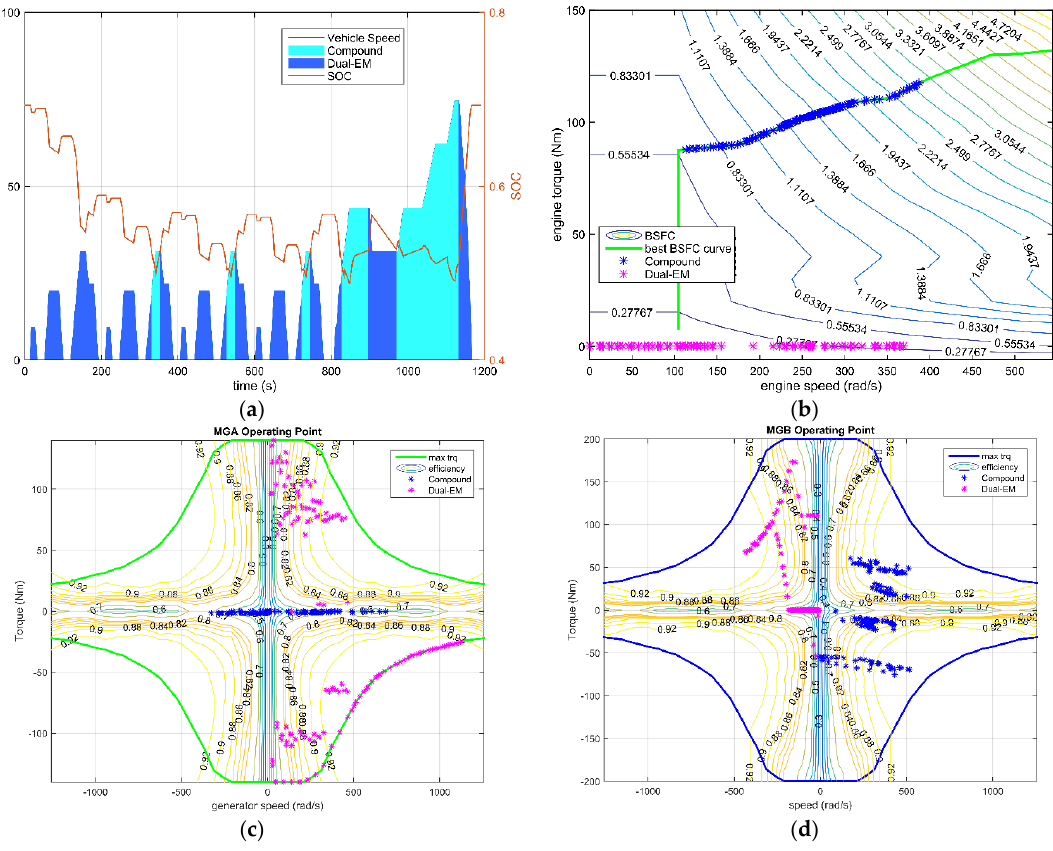
Figure 14. ( a ) Battery SoC trajectory and mode selection during theNEDC drive cycle; ( b ) engine optimal operation points during the NEDC drive cycle; ( c ) EMA operating points over the NEDC drive cycle; and ( d ) EMB operating points over the NEDC drive cycle cycle; and ( d ) EMB operating points over the NEDC drive